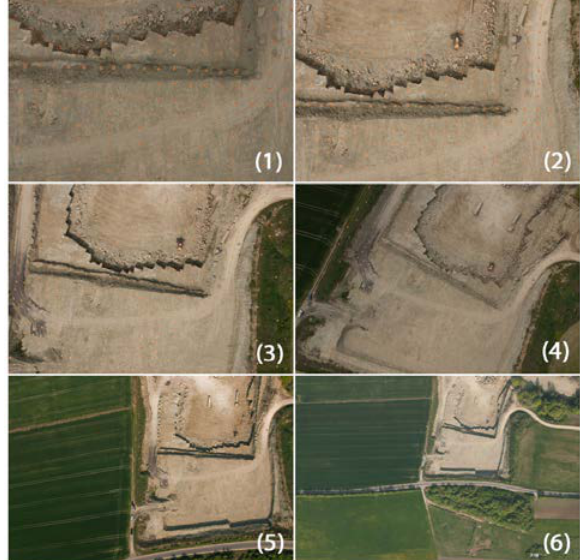
Figure 3. Aerial images of different flight altitudes used for quantification of the indirect sensor orientation accuracy (1: 70m, 2: 100m, 3: 150m, 4: 200m, 5: 300m, 6: 550m)